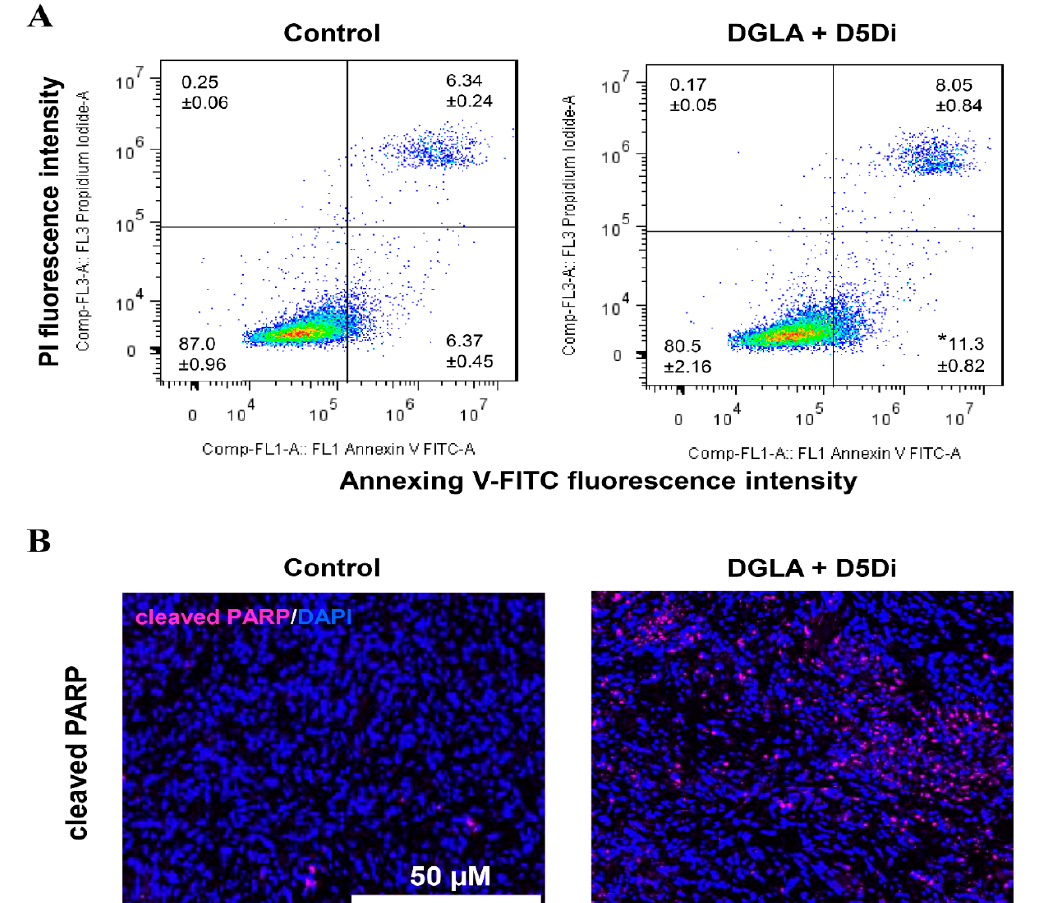
Figure 6. Effect of delta-5-desaturase (D5D) inhibitor on lung cancer apoptosis. ( A ) Cell apoptosis determined by flow cytometry. ( B ) Immunofluorescence images of cleaved poly (ADP-ribose) polymerase (PARP) in lung tumor tissues. * p < 0.05 vs. Control group. Data represent mean ± SEM, unpaired t-test. Table 2. The composition of each sample for A549 cells treated by 8-hydroxyoctanoic acid (8-HOA), Prostaglandin E2 (PGE2), dihomo- γ -linolenic acid (DGLA), delta-5-desaturase inhibitor (D5Di), and DGLA + D5Di.